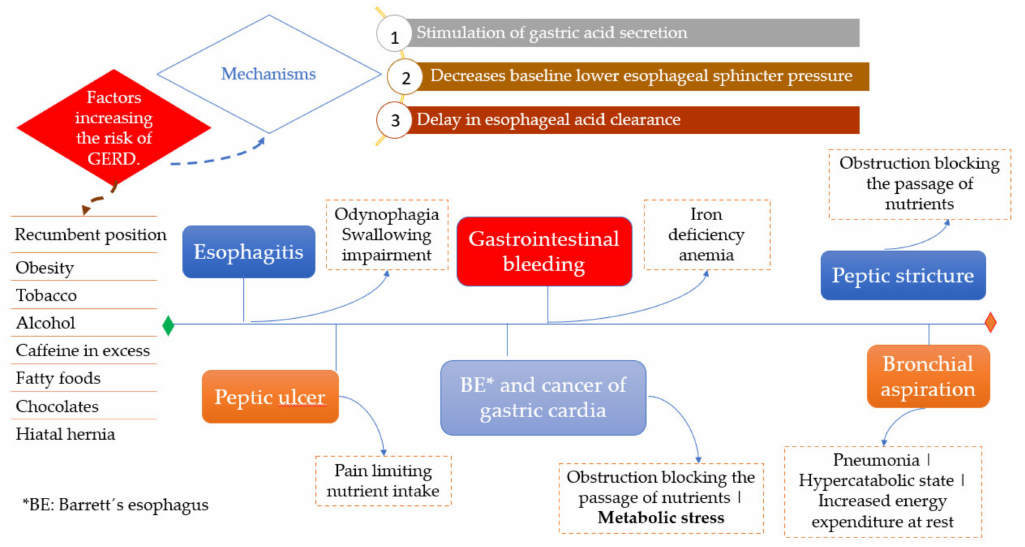
Figure 7. Precipitating factors of GERD, complications, and effects on nutritional